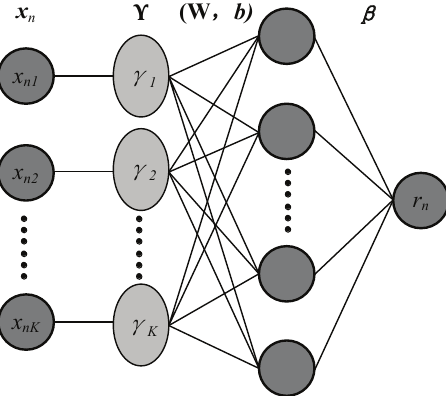
Figure 4. The structure of the weighted extreme learning machine (WELM)